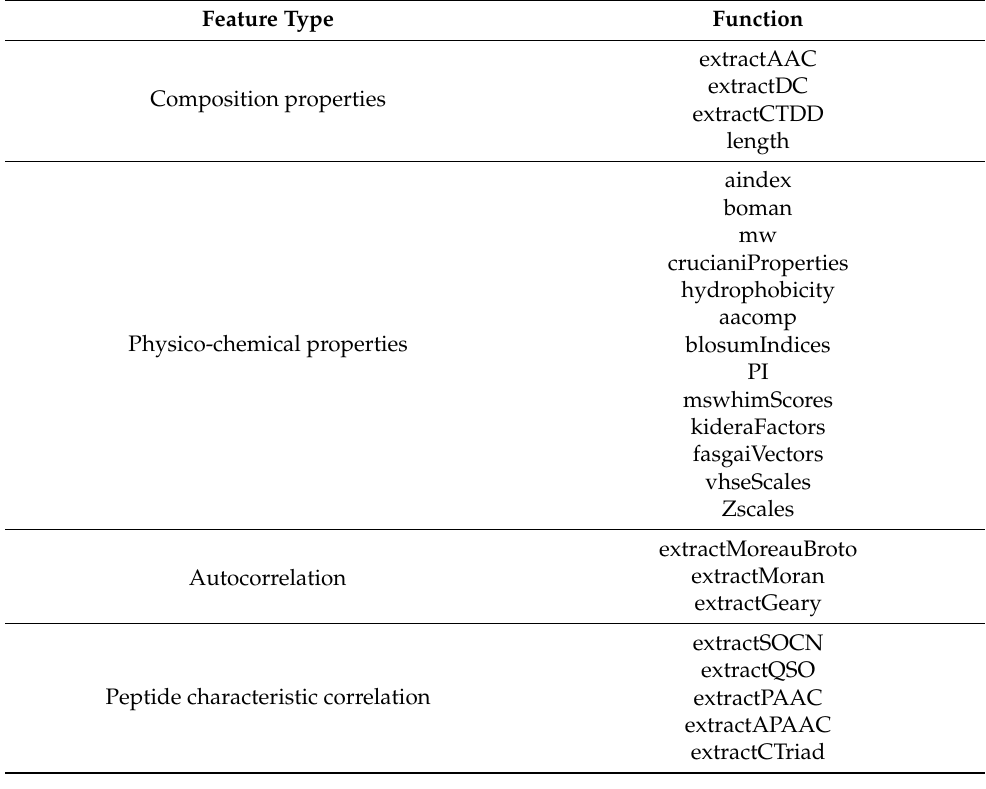
Table 1. Functions of the peptides and Protr packages for feature